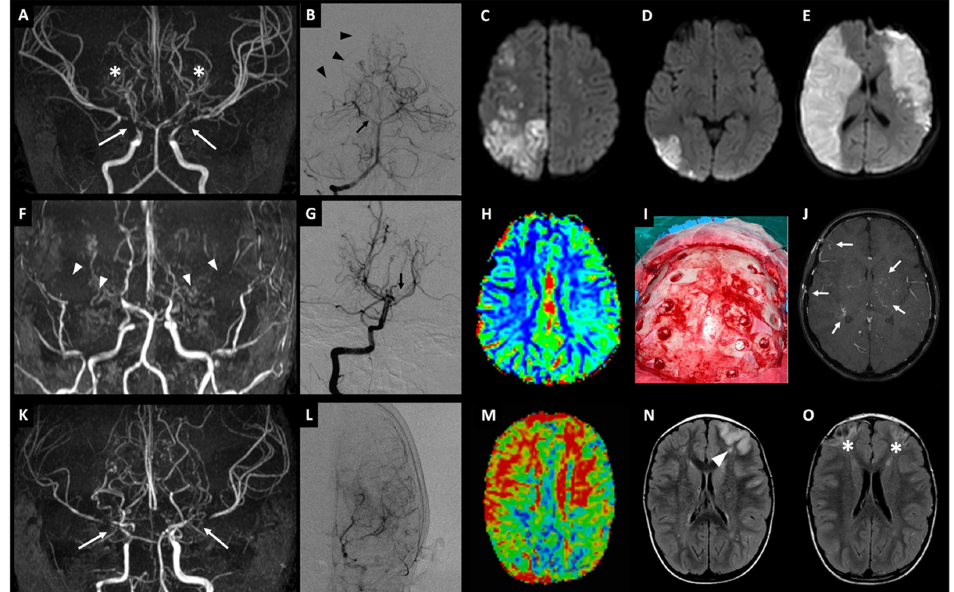
Figure 2. Imaging from probands of families A-C with bilateral moyamoya. Family A, patient II.1 ( A – E ): Magnetic resonance angiography (MRA) image showing severe bilateral narrowing of internal carotid arteries (ICAs; white arrows) and typical hypertrophic perforating collateral vessels (“puff of smoke” appearance; white asterisks) ( A ); vertebral digital subtraction angiogram showing stenosis of the right posterior cerebral artery (PCA; black arrow) and a less extensive pial network (black arrowheads) ( B ); diffusion-weighted MR images showing acute ischemic strokes in parietal and temporo-occipital areas at onset ( C , D ) and subsequent massive bilateral strokes in middle cerebral artery districts on the first postoperative day ( E ). Family B, patient III.2 ( F – J ): MRA image showing severe bilateral narrowing of internal carotid arteries with moyamoya collateral vessels and lack of both proximal anterior and middle cerebral arteries (white arrowheads) ( F ); vertebral angiogram showing stenosis of the left PCA (black arrow) ( G ); cerebral blood flow (CBF) map of MR perfusion study showing impaired cerebral perfusion, especially in the left hemisphere ( H ); intraoperative image of indirect revascularization obtained by one-stage bilateral multiple burr holes technique ( I ); follow-up MRA image showing hypertrophic collateral network at the basal ganglia and along the postoperative dural surface (white arrows) ( J ). Family C, patient III.3 ( K – O ): MRA images showing typical moyamoya pattern with severe bilateral stenosis of the terminal ICA, A1, and M1 segments (white arrows), and hypertrophic deep vessels ( K ), confirmed on angiography ( L ); mean transit time (MTT) map of MR perfusion study showing prolongation of MTT due to impaired perfusion in bilateral anterior districts ( M ); MR fluid-attenuated inversion recovery (FLAIR) images showing acute ischemic left frontal stroke at onset (white arrowhead) ( N ) and delayed bilateral frontal ischemic lesions after one year (white asterisks) ( O